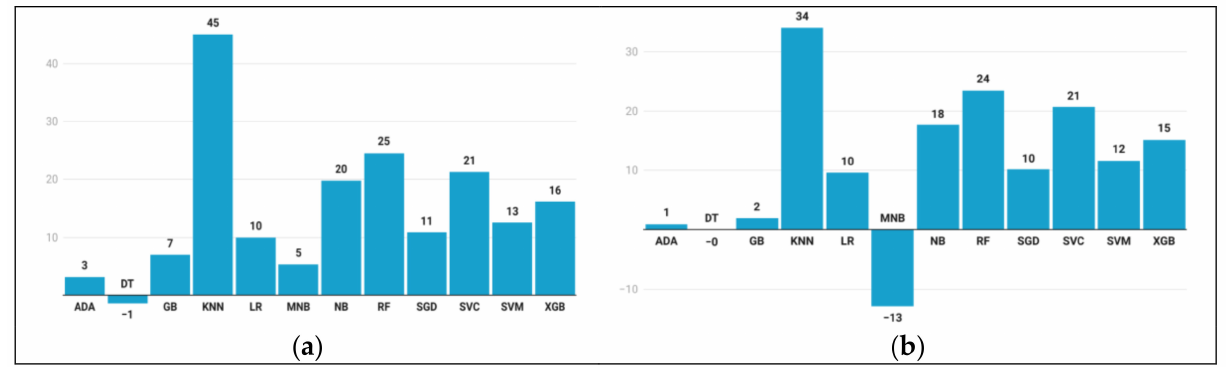
Figure 5. F1 score improvement: ( a ) dataset 1; ( b ) dataset